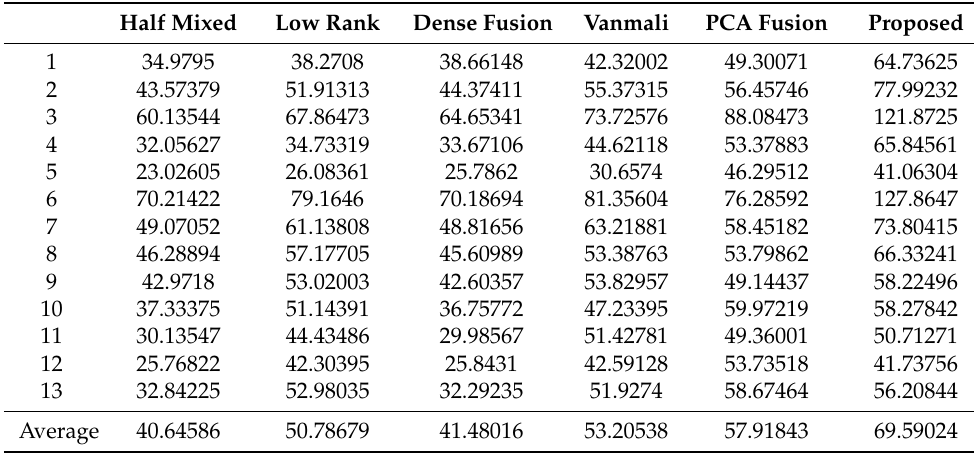
Table 5. Comparison of the edge intensity